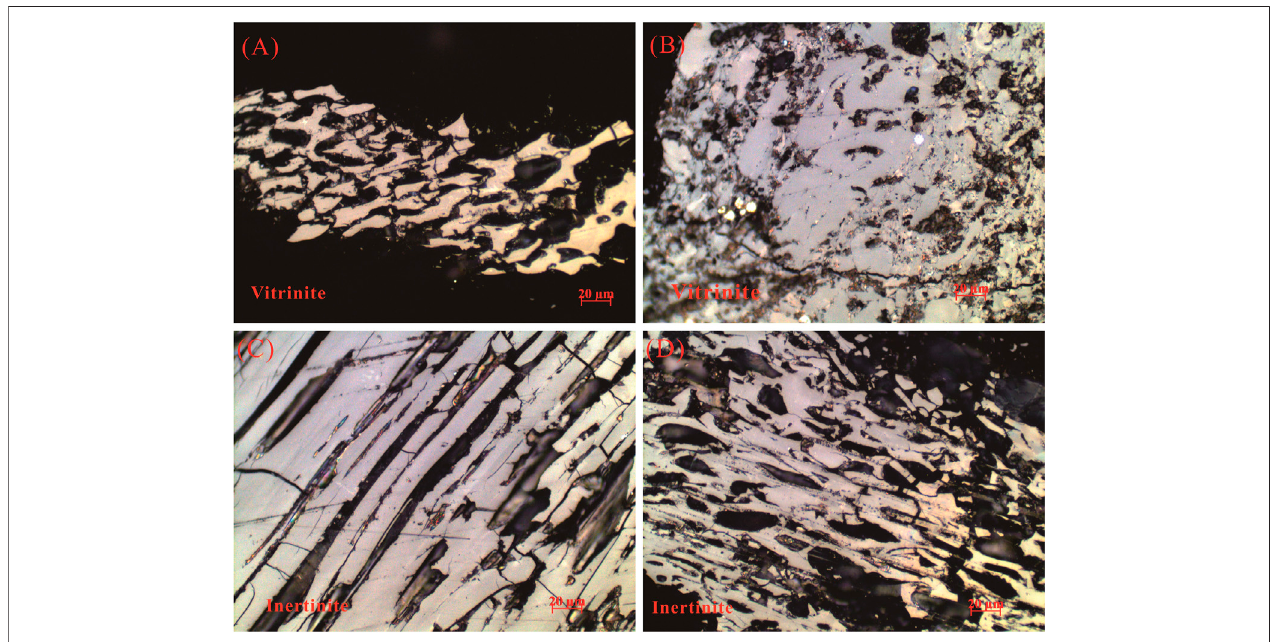
FIGURE 6 | Organic maceral. (A,B) Vitrinite. (C,D) Inertinite.